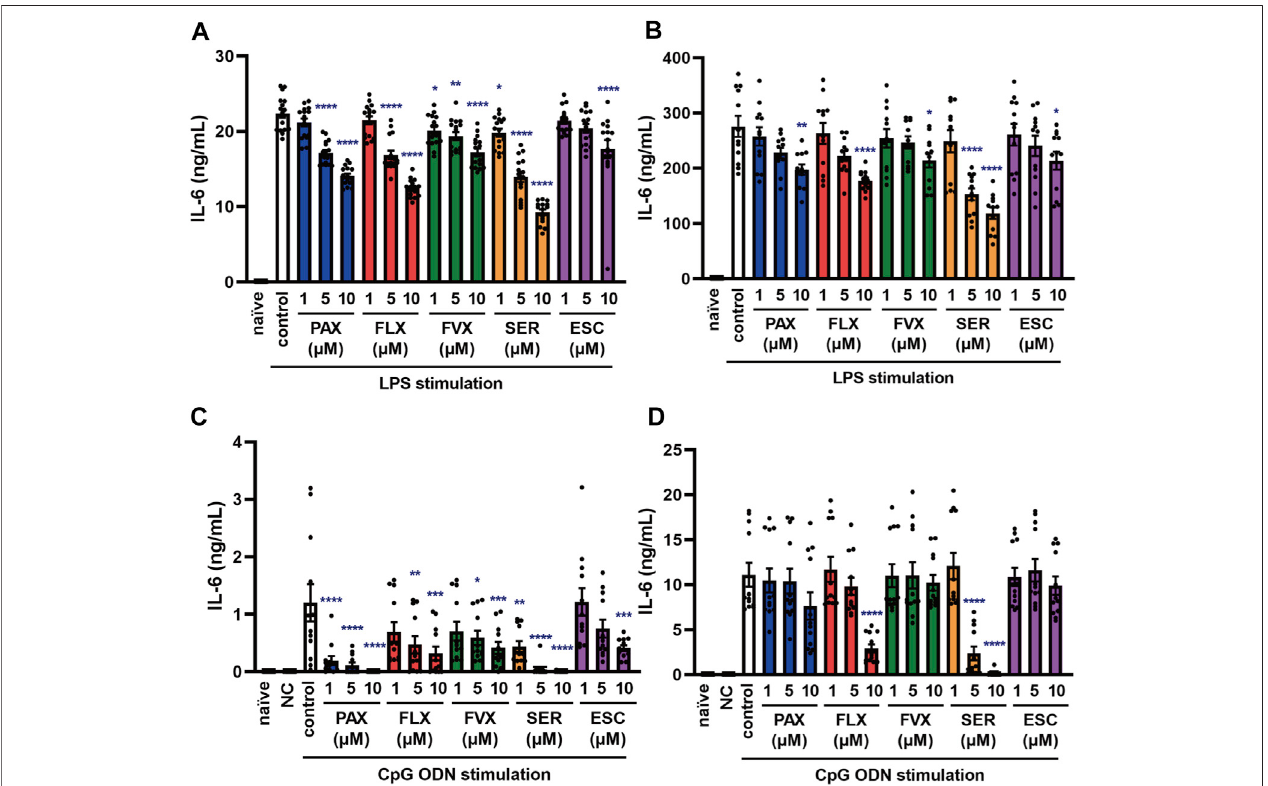
FIGURE 3 | Effects of SSRIs on IL-6 production induced by TLR4 or TLR9 agonist in J774.1 murine macrophage cells. J774.1 cells were pre-incubated with each SSRI(1 – 10 µM)for30 minandthenincubatedwithLPS(1 μ g/ml)for6 h (A) or24 h (B) ,orwithCpGODNornegativecontrolODN(200 ng/ml)for6 h (C) or24 h (D) .IL- 6 was measured by means of ELISA. Error bars indicate ±SE [ (A) : n = 16, (B – D) : n = 12, three or more independent experiments]. Statistical analysis was performed by one-way ANOVA followed by Dunnett ’ s test. Signi fi cant differences between control and test groups are indicated by * p < 0.05, ** p < 0.01, *** p < 0.001, **** p < 0.0001. NC, negative control ODN. PAX, paroxetine; FLX, fl uoxetine; FVX, fl uvoxamine; SER, sertraline; ESC,